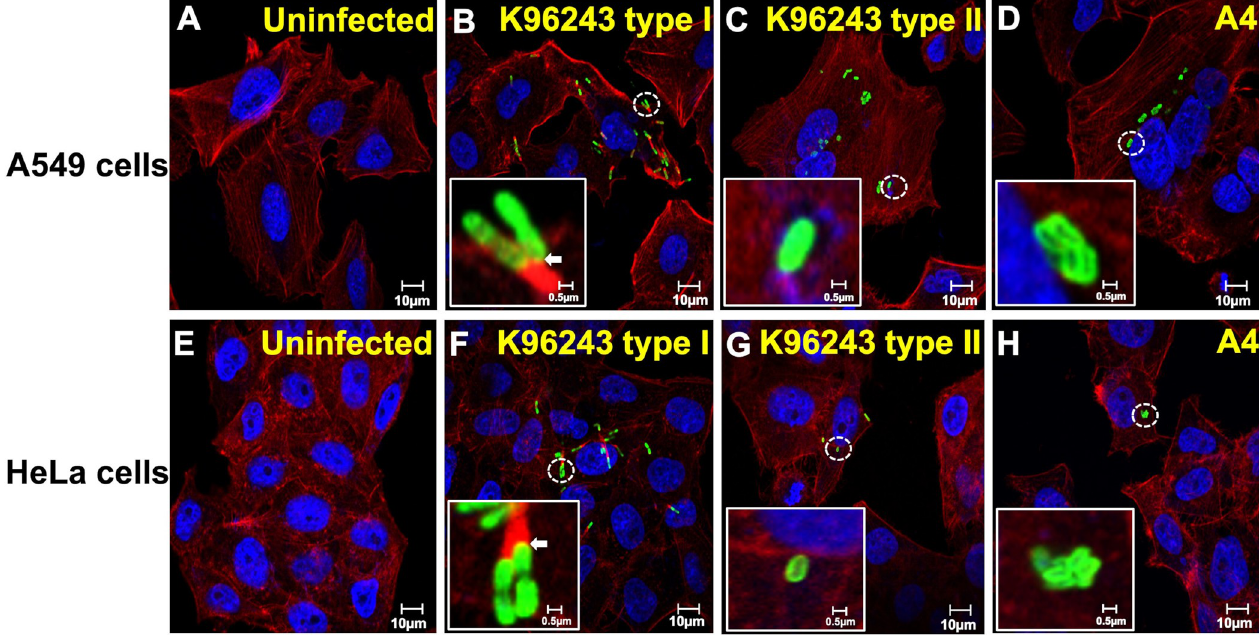
Fig 2. B . pseudomallei K96243 type II and A4 do not induce actin-tail formation in A549 and HeLa cells. A549 cells (A) and HeLa cells (E) were infected with B . pseudomallei K96243 type I (B and F), K96243 type II (C and G) and A4 (D and H) at MOI of 50. Immunofluorescence staining was performed at 8 h post-infection. The cells were stained with monoclonal antibody 4B11 specific to B . pseudomallei capsular polysaccharide to indicate bacteria in green, phalloidin to indicate F-actin in red and Hoechst 33258 to indicate host DNA in blue. The co-localization between bacteria and actin is shown in yellow (arrows). Scale Bars, 0.5 and 10 μ